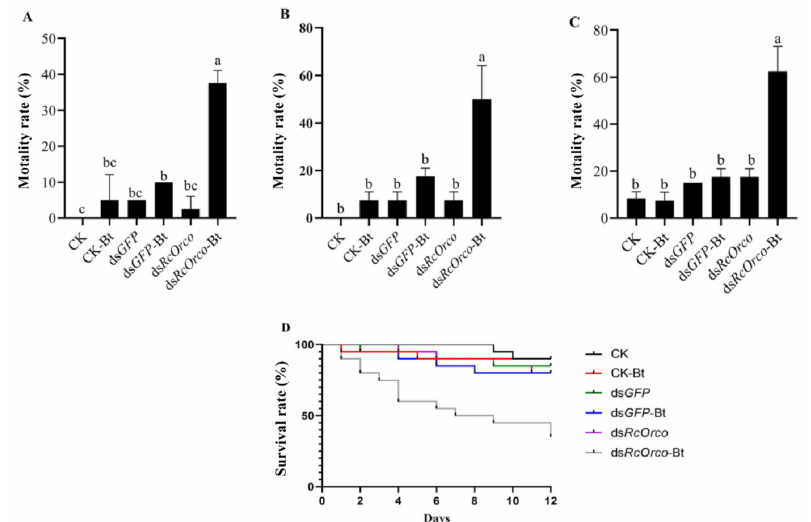
Figure 4. Bioassay of dsRcOrco combined with Bt in R. chinensis . ( A ) Mortality rate of each treatment group at 4 d. ( B ) Mortality rate of each treatment group at 8 d. ( C ) Mortality rate of each treatment group at 12 d. ( D ) Survival rate of each treatment group. The letters above the columns indicate different expressive